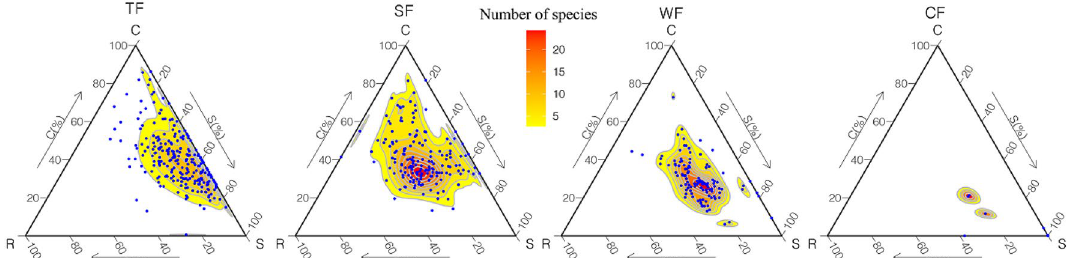
Figure 1. Distribution of species’ ecological strategies in the C-S-R triangle of typical forest vegetation types across four climatic zones in China. TF tropical rainforest, SF subtropical evergreen-deciduous broadleaved mixed forest, WF warm-temperate coniferous-broadleaved mixed forest, CF cold-temperate coniferous forest. The numbers of species gradient in typical forest vegetation types are visualized by colored polygon. Blue dot represents individual species. Deeper shades of color correspond with greater number of species. The C (%), S (%) and R (%) each represent the components C, S and R in C-S-R